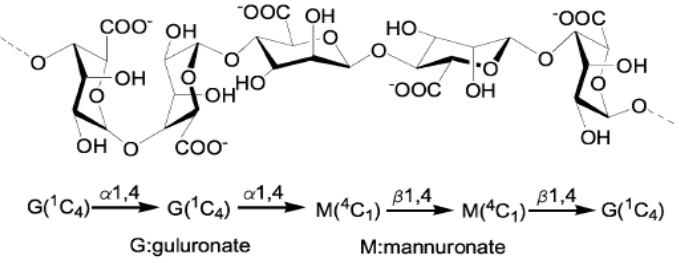
Figure 1. Seaweed glue molecular structure (monomer subunits, G—polyguluronic, M—polymannuronate) [20]. Reproduced with permission from Treenate et al., In vitro drug release profiles of pH-sensitive hydro-xyethylacryl chitosan/sodium alginate hydrogels using paracetamol as a soluble model drug; published by Elsevier, 2017.